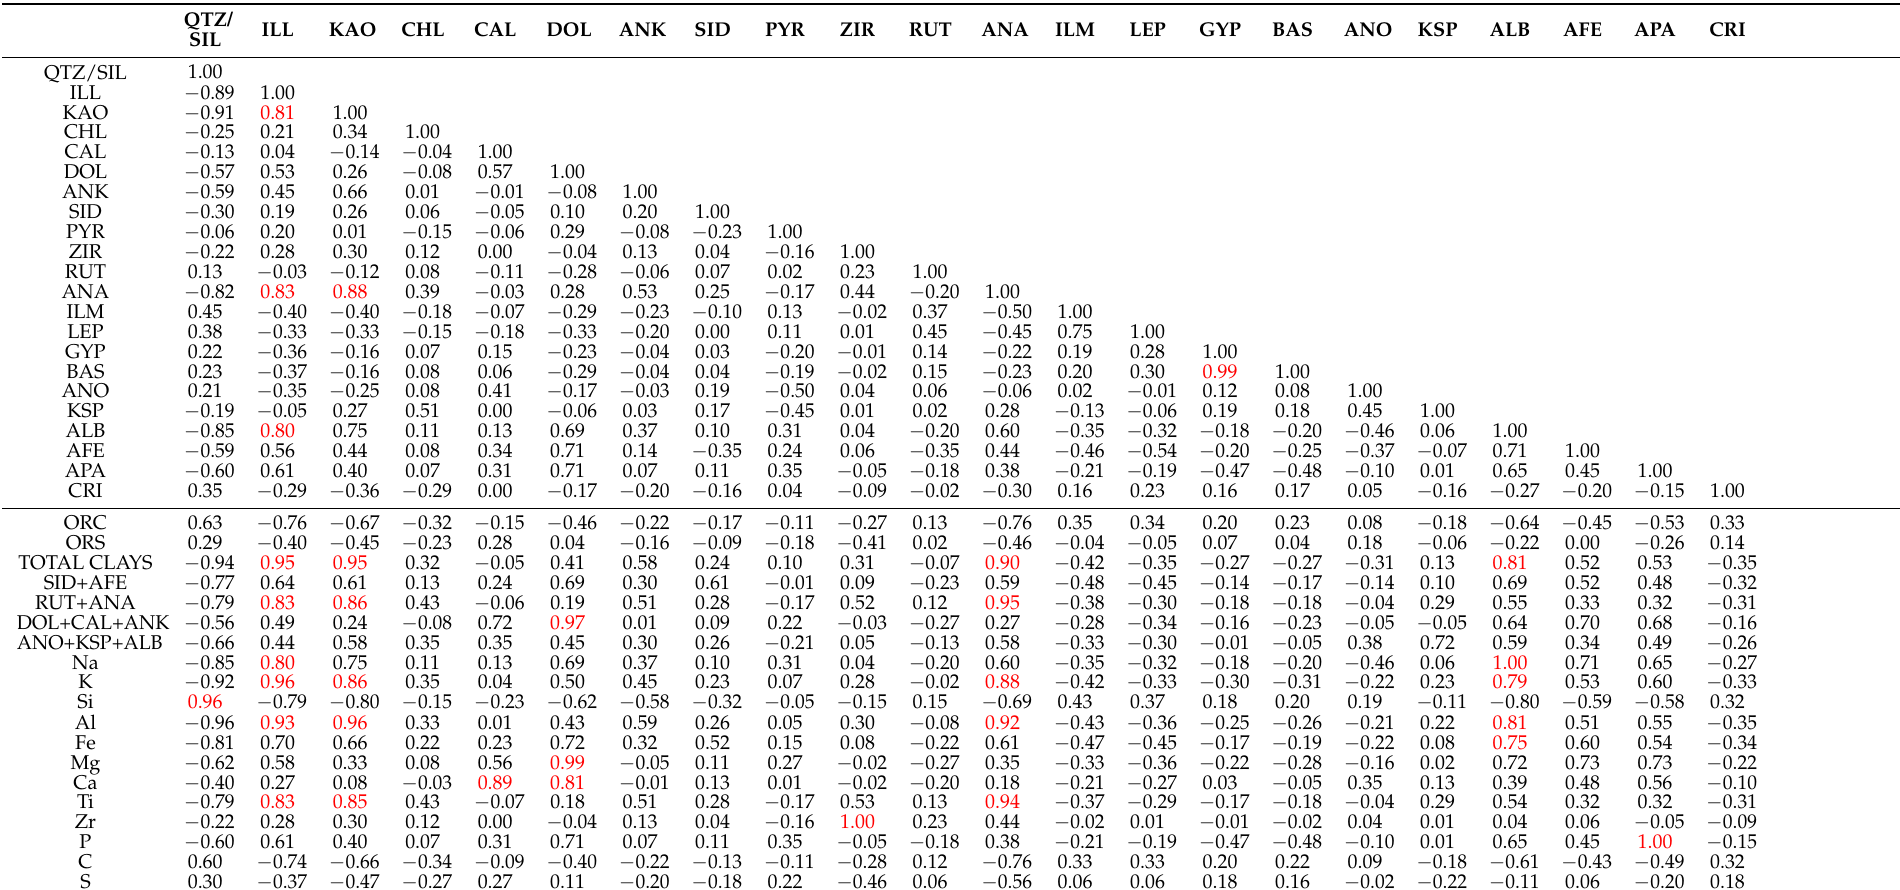
Table A1. Correlation matrix for all 46 variables (including 5 composites) used in PLS regression model. Coefficients greater than 0.75 are indicated by red